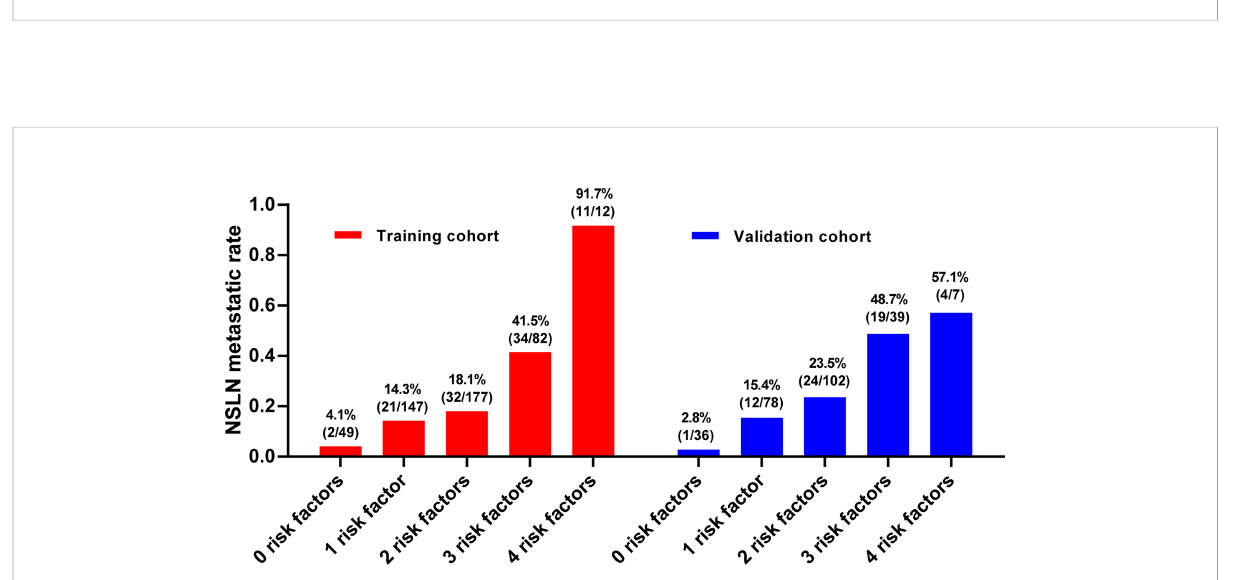
FIGURE 3 The NSLN metastatic rate when there are zero to four risk factors. The risk factors include (1): negSLN <3 (2); tumor size >20 mm (3); tumor location in the upper outer quadrant (4); presence of lymph-vascular invasion. LVI, lymph-vascular invasion; negSLN, number of negative SLNs; NSLN, non-sentinel lymph